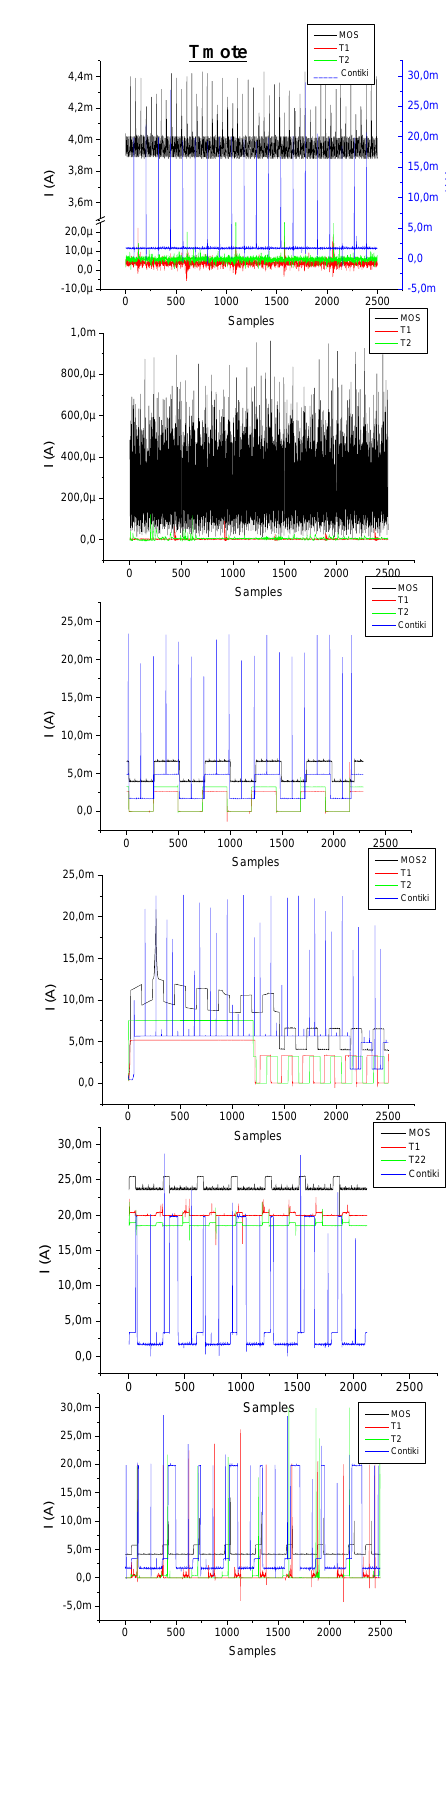
Figure 1. Instant current consumption of each application for both